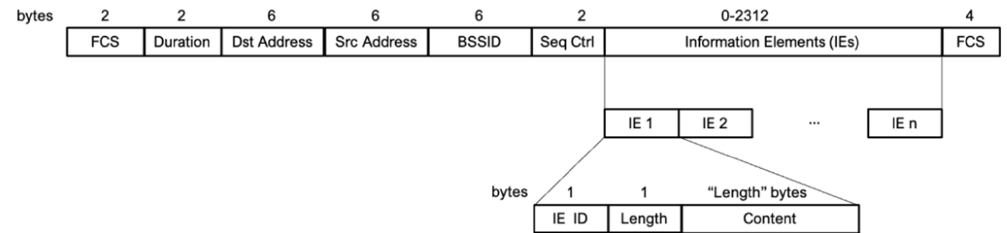
Figure 5. IEEE 802.11 probe request frame format.